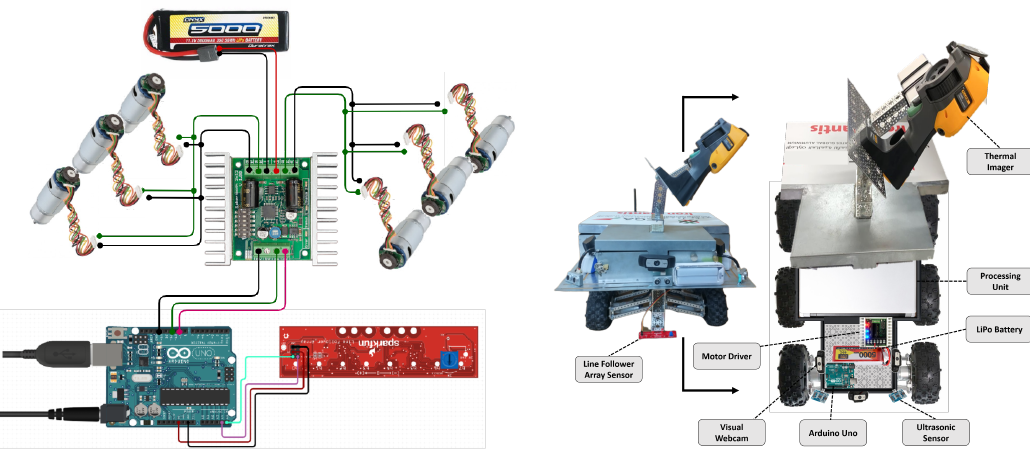
Figure 5. Mechanical and electronic